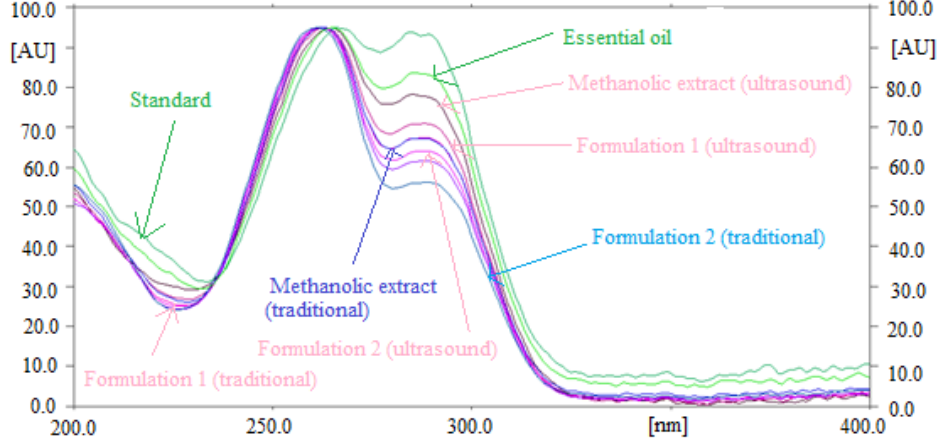
Figure 2. Overlaid ultraviolet (UV) absorption spectra of standard TAL, fennel essential oil and traditional and ultrasound-assisted fennel extract and commercial formulations.